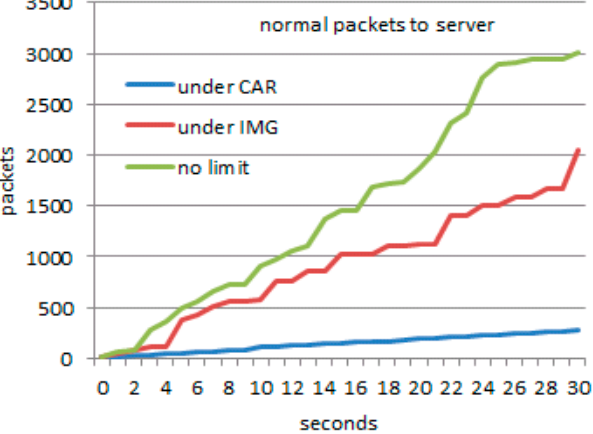
Figure 23. Comparison of the legit packets transmitted under CAR /IMG/No limit.